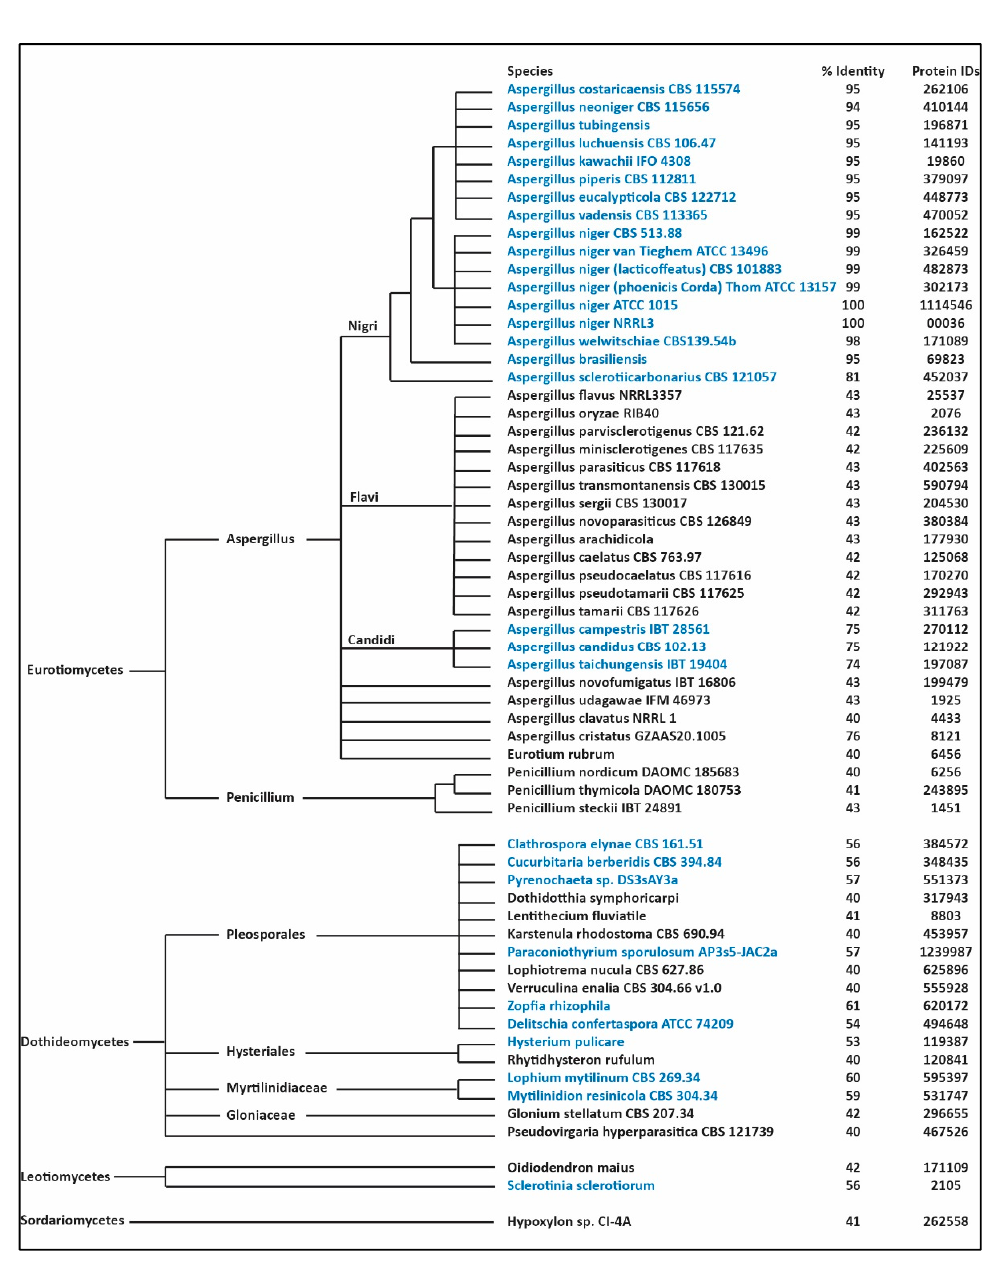
Figure 2. Phylogenetic tree built from orthologs of NRRL3_00036. Highlighted in blue are the syntenic species. The protein identification numbers (IDs) refer to the NRPS orthologs as assigned in the JGI MycoCosm database [13].